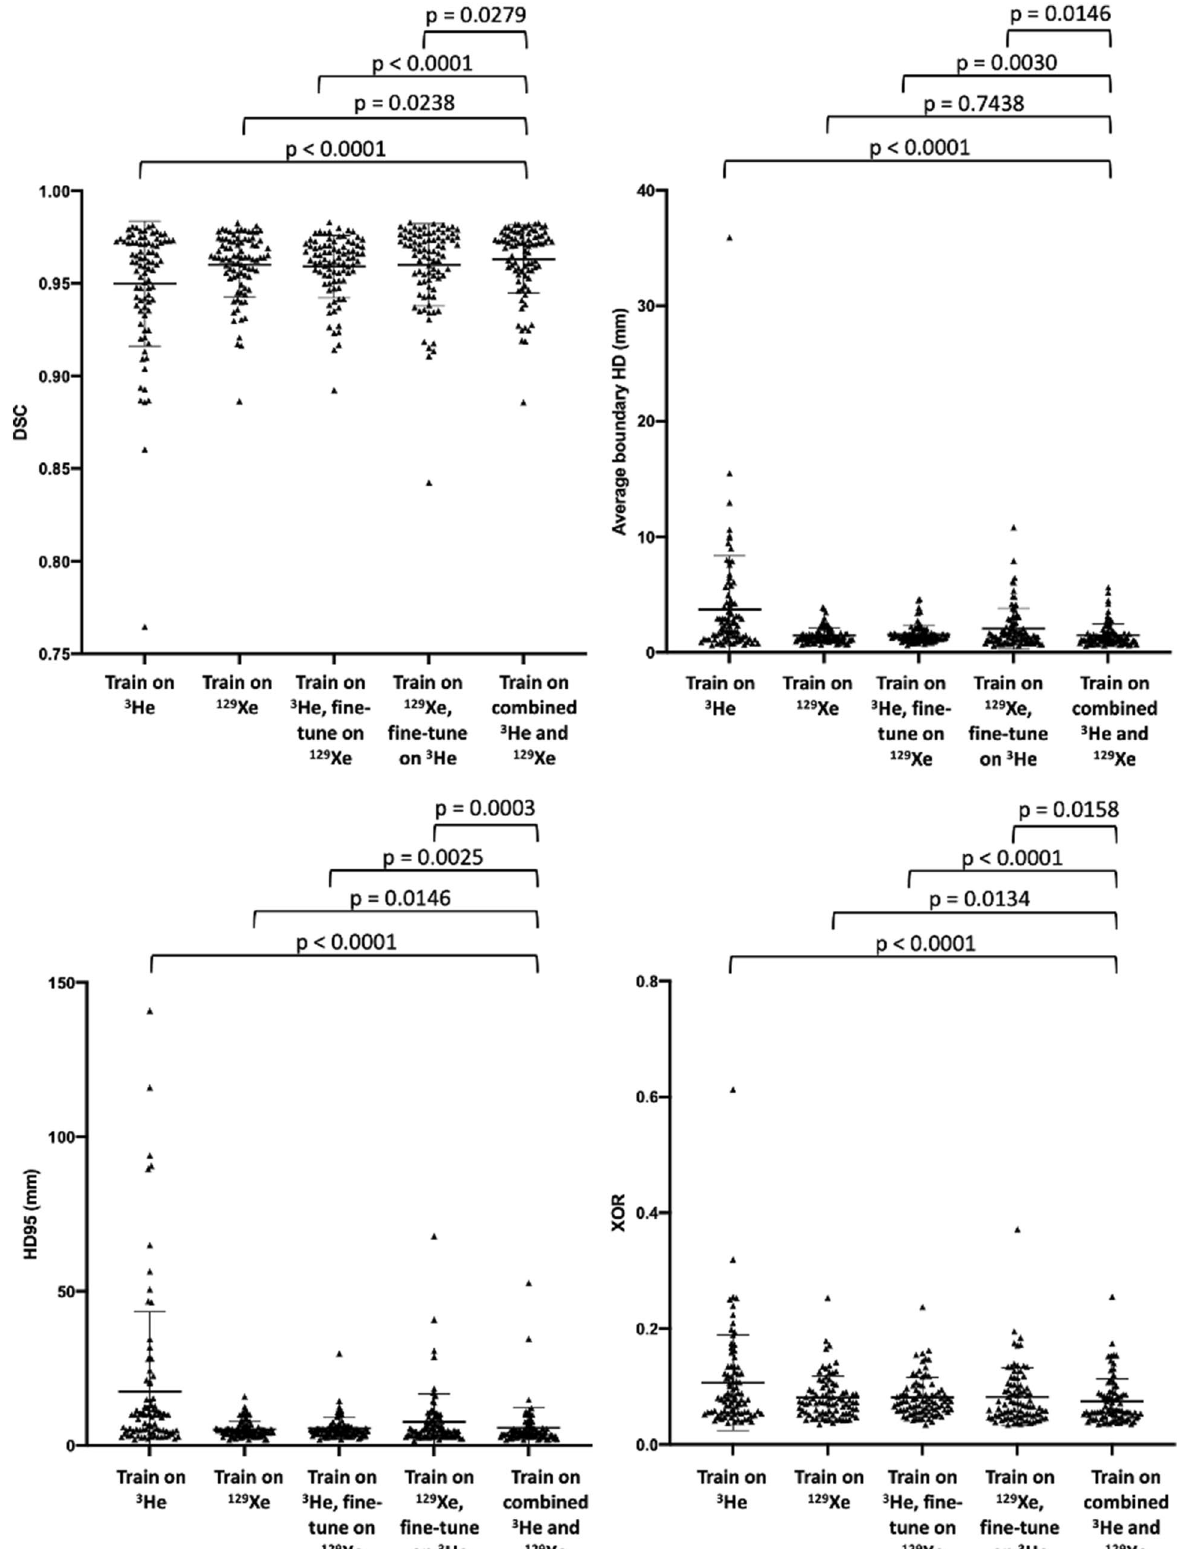
Figure 3. Comparison of segmentation performance on 86 testing scans for five DL experimental methods using the DSC, Avg HD, HD95 and XOR metrics (left to right). P-values are displayed for Friedman tests with Bonferroni correction for multiple comparisons, comparing the combined 3 He and 129 Xe DL method to the other DL methods. Mean and standard deviation values are marked by a bold line and whiskers,